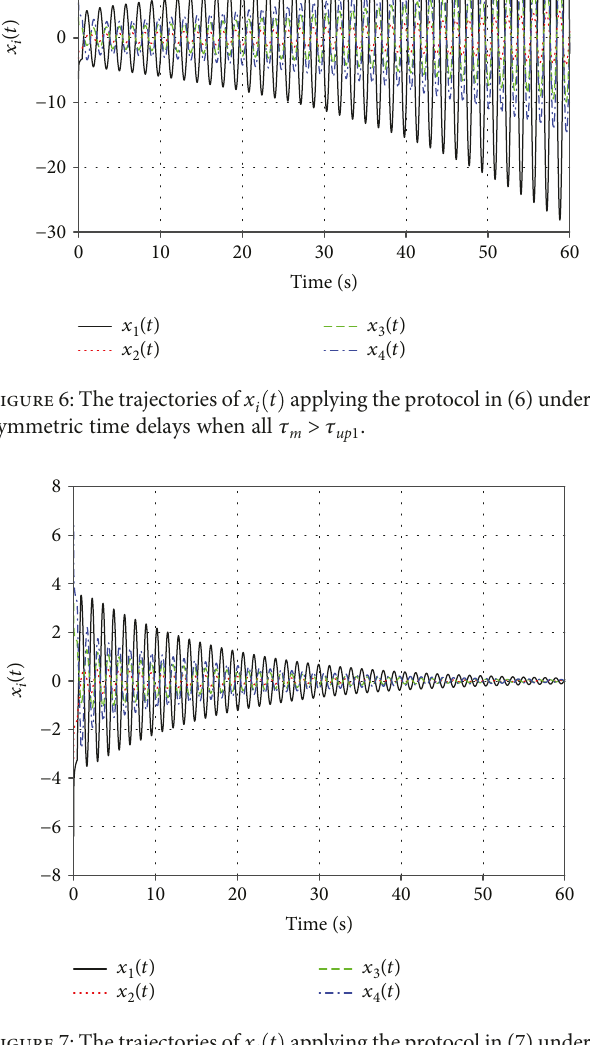
Figure 7: The trajectories of x symmetric time delays when all τ m < τ up